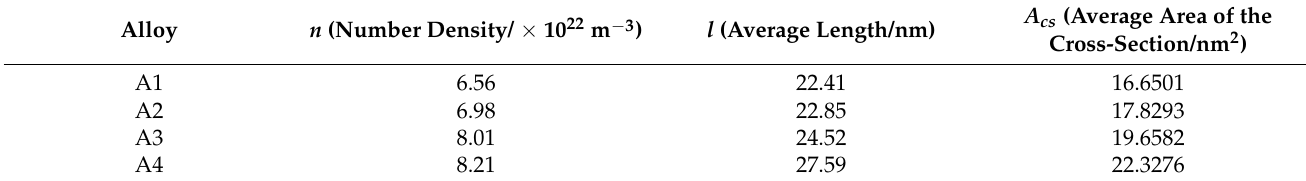
Figure 5. Bright-field TEM images of the alloys after aging treatment ( a ) A1, ( b ) A2, ( c ) A3, ( d ) A4. Table 2. Number density of precipitate in aging-treated samples.